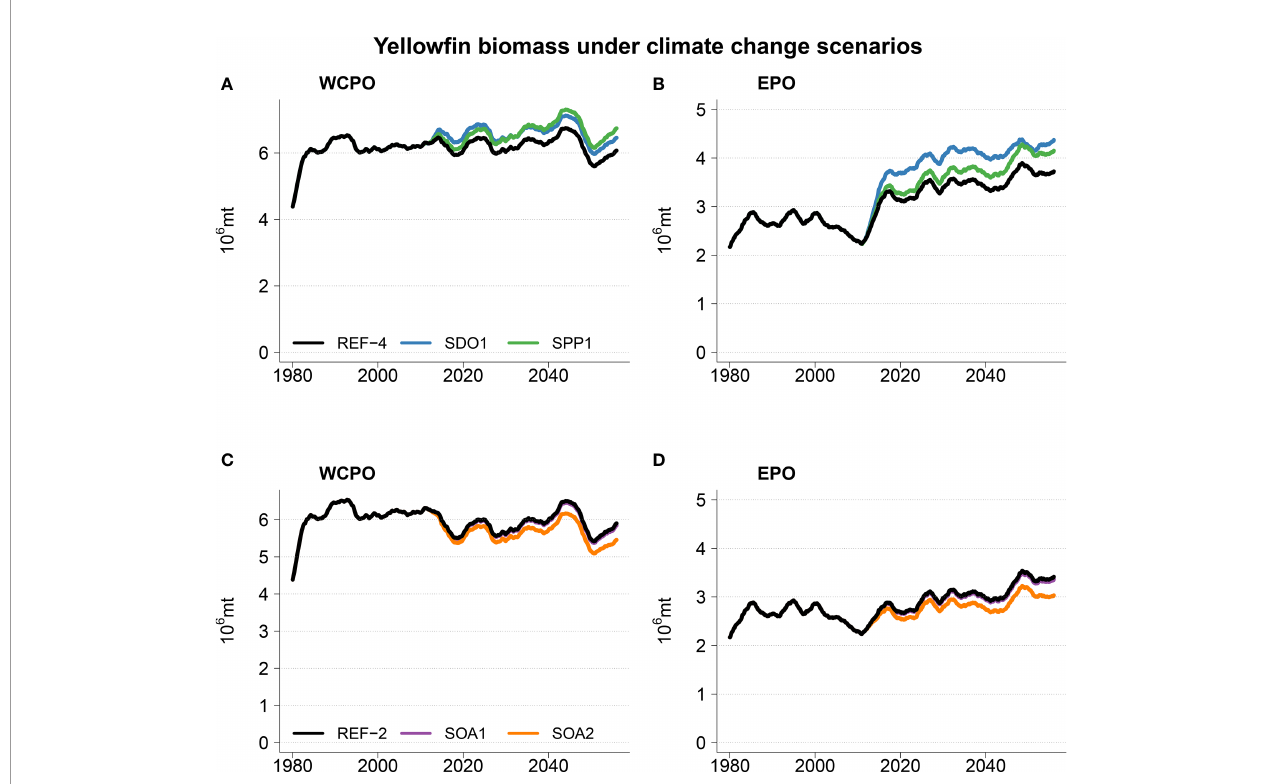
FIGURE 5 | Top panels (A, B) projection mean of total yellow fi n biomass for scenarios REF4 (reference), SPP1 (primary production), and SDO1 (no change in dissolved oxygen concentration). Bottom panels (C, D) projection mean of total yellow fi n biomass for scenarios REF2 (reference), SOA1 (intermediate impact of ocean acidi fi cation on larval mortality) and SOA2 (high impact of ocean acidi fi cation on larval mortality). Note that SOA1 and REF2 are